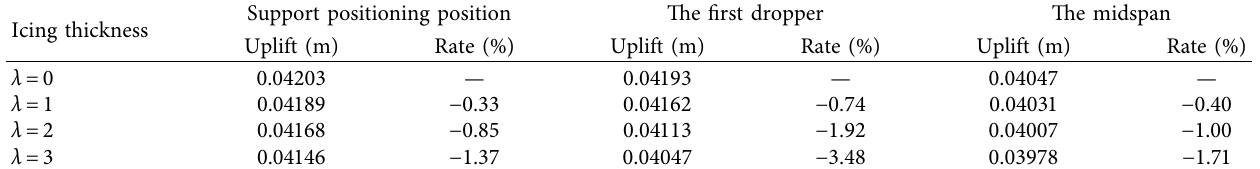
Table 5: Statistical value of uplift at different positions after icing (uniform load method). Icing